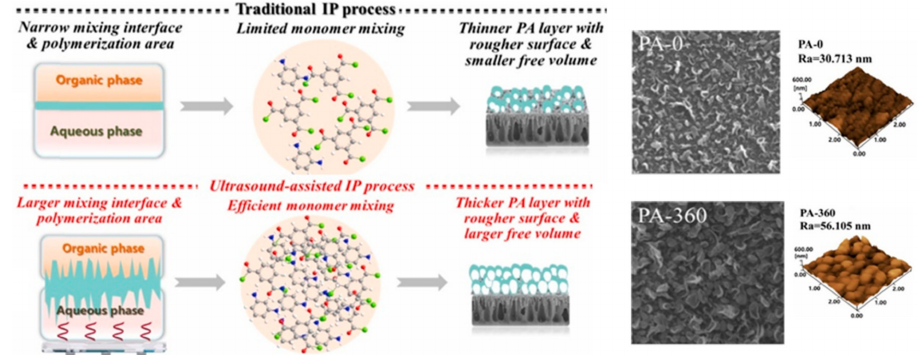
Figure 9. Schematic diagram, SEM and AFM images of traditional IP and UAIP process for membrane preparation (Note: PA-0—conventional TFC membrane; PA-360—ultrasonic-assisted TFC membrane